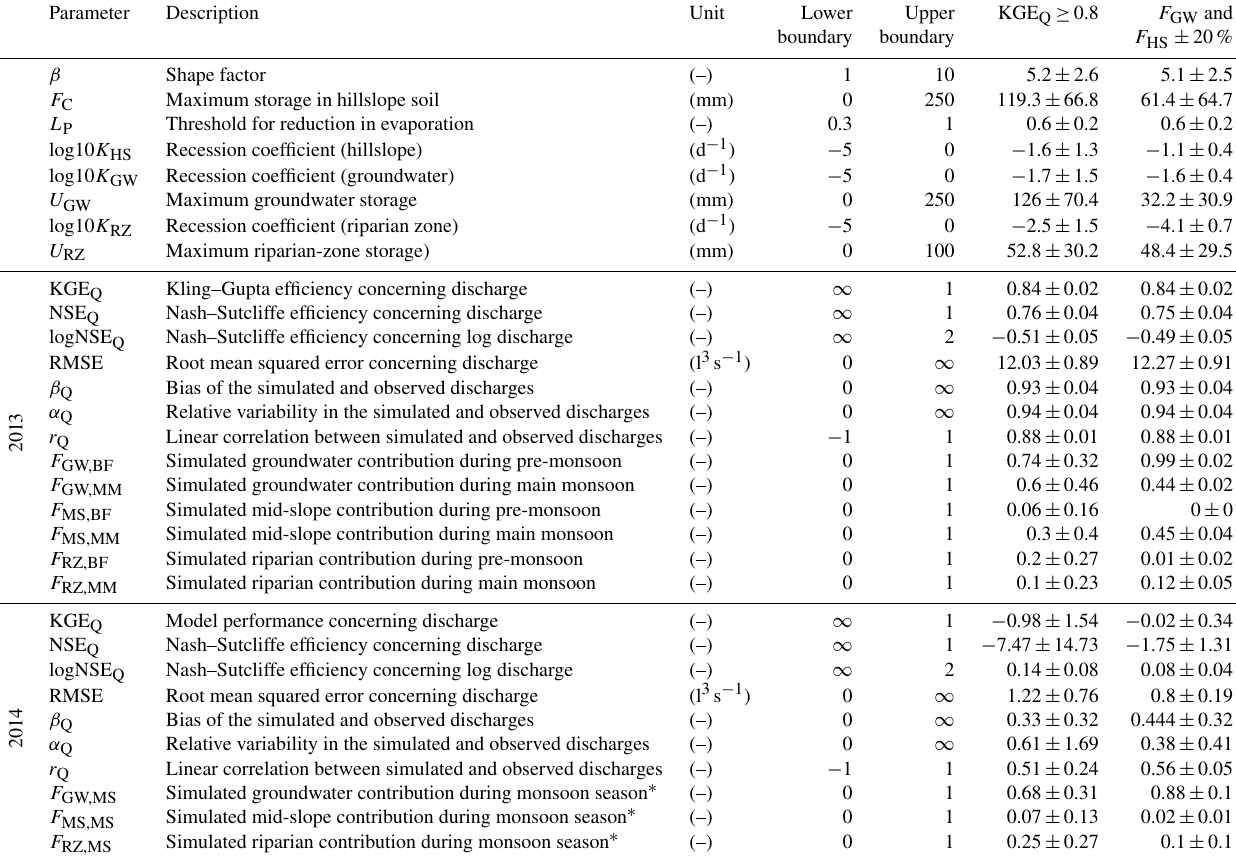
Table 1. Parameters of the modified HBV model, description, units, and boundaries for parameter estimation (see below) and the model per- formances and simulated streamflow components for the two delineated monsoon periods (see Sect. 2) when confining the initial parameter sample by discharge only and by discharge and tracer-based contributions to streamflow for the calibration in 2013 and the validation in 2014.